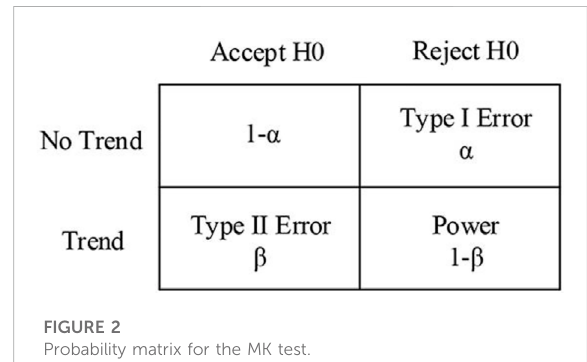
FIGURE 2 Probability matrix for the MK